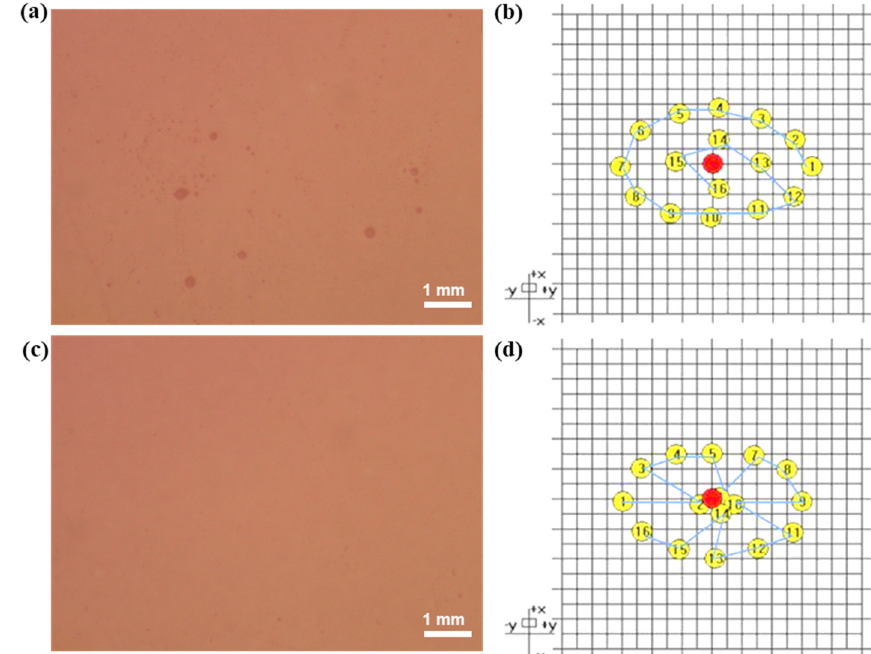
Figure 6. ( a ) Micrograph of the film surface before optimization. ( b ) Original diagram of the electron beam melting path. ( c ) Micrograph of the optimized film surface. ( d ) Optimized diagram of the electron beam melting path, the obscured numbers are 2, 6, 10 and 14 in clockwise order. The numbers 1–16 indicate the trajectory of the electron beam.